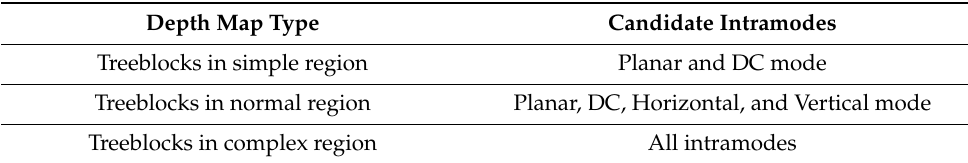
Table 7. Optimal intramode for each type